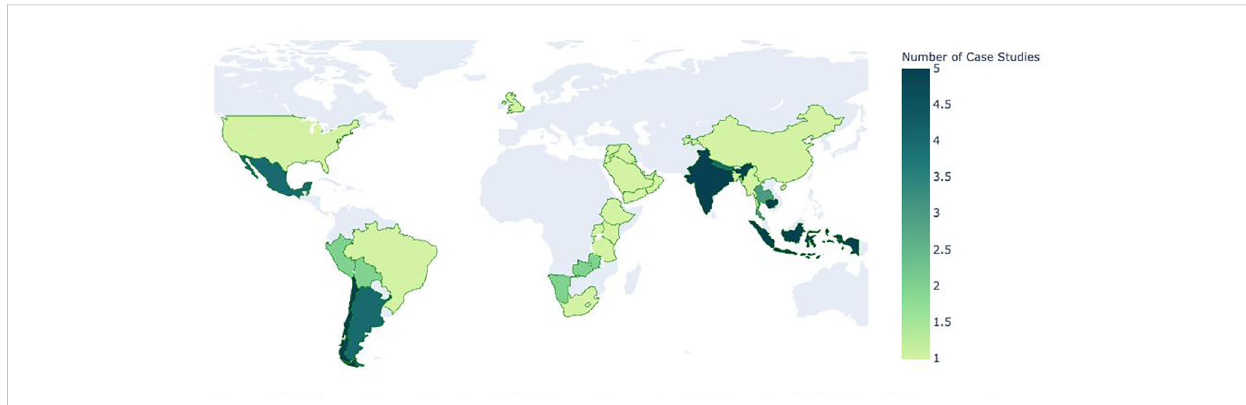
FIGURE 1 Global map of the countries where included case studies were located. Darker coloration indicates a higher number of case studies representing that